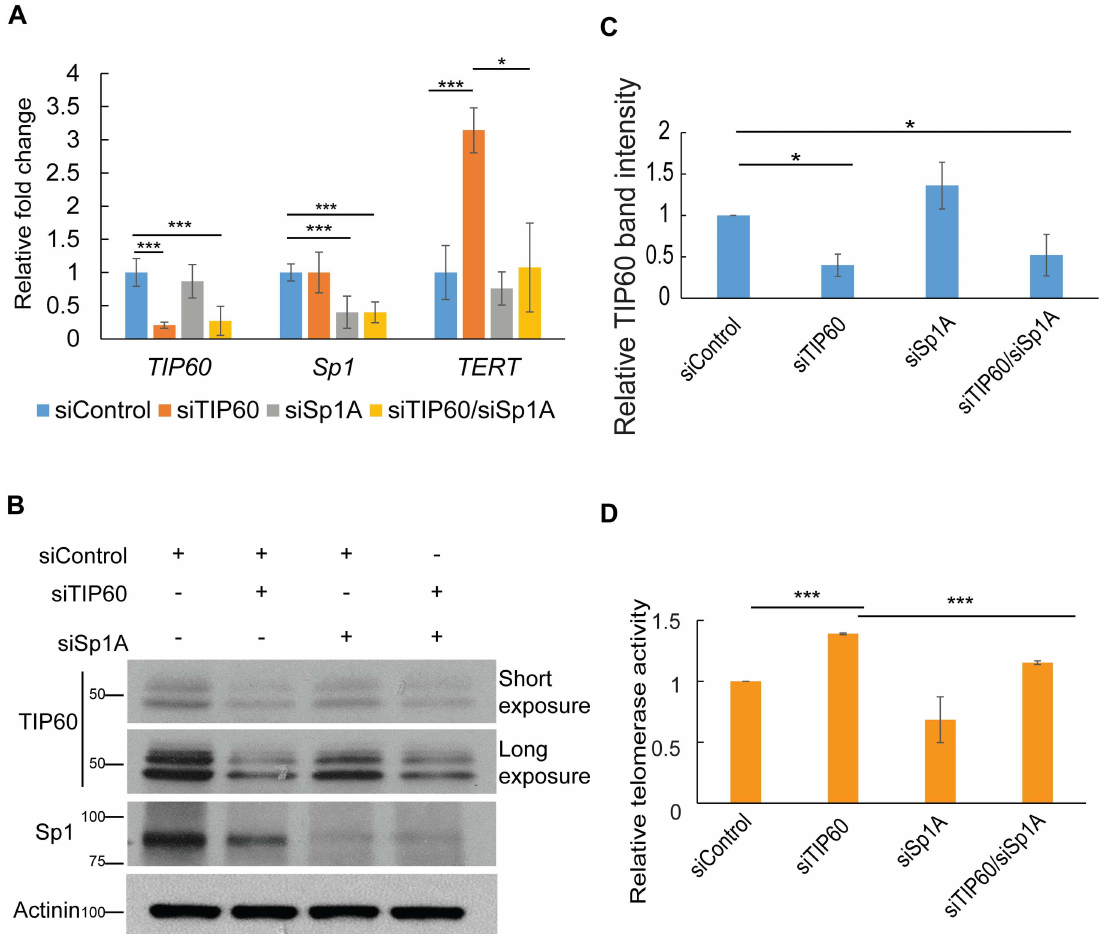
Fig 3. TIP60 inhibits Sp1 function. (A, B) TIP60 and Sp1 were depletedin HeLa cells using siRNA transfection. Cells were harvested72 h post transfection, RNA and protein was isolated to use for real time PCR and western blottinganalysis. Real- time PCR analysiswas used to study TERT expressionupon TIP60 and Sp1 knockdown.All mRNA expressiondata was normalizedto GAPDH and plotted as fold change.EndogenousTIP60 and Sp1 were detected using anti-TIP60 and anti-Sp1 antibodiesrespectively. All the bands observedwhen probedwith anti-TIP60 correspondto TIP60 protein since they are specificallyreducedupondepletionof TIP60. α -Actininserves as the loadingcontrol for the western blot. ( C ) Quantification of TIP60 bandsusing Image J software, from three independentexperiments has also been depicted. (D) Relative telomerase activity was measuredby qTRAP in the same set of samples. Error bars reflect the standarderror of mean (SEM) of